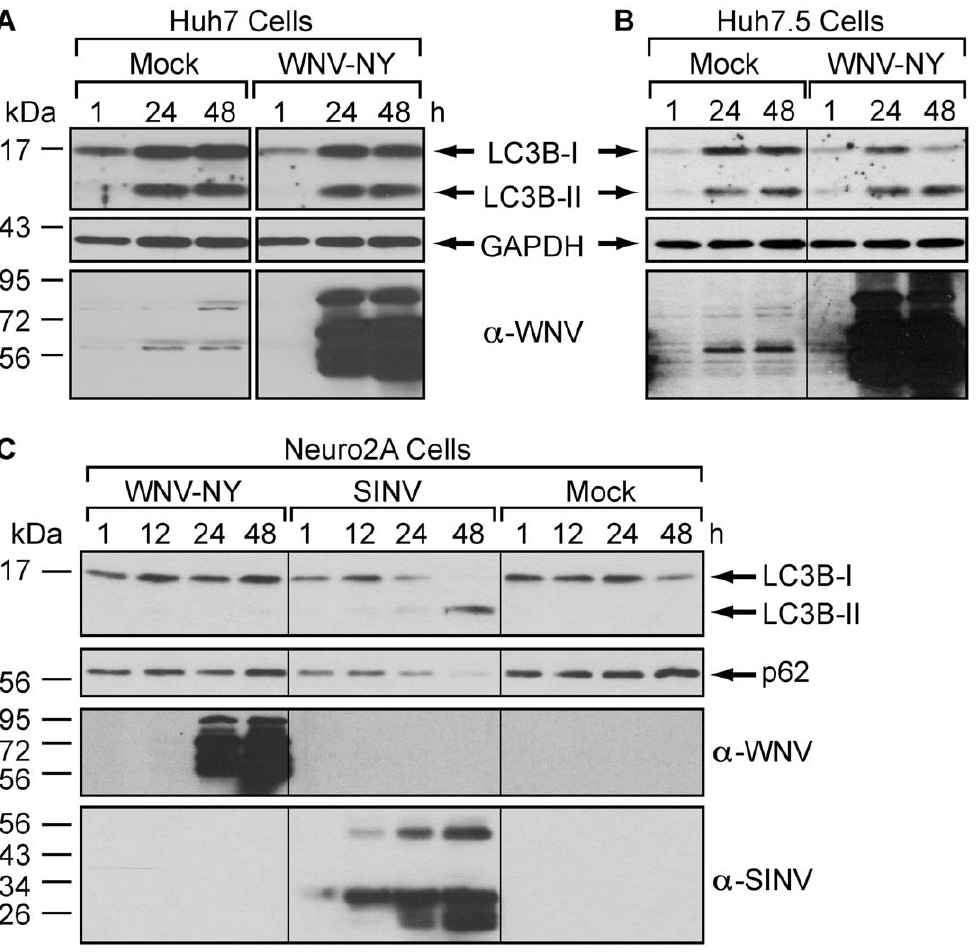
Figure 5. The autophagy pathway is not upregulated by WNV in established cell lines. (A and B) Effect of WNV infection on steady-state LC3B-II levels in Huh7 (A) or Huh7.5 (B) cells. Following mock or WNV-NY (MOI=3) infection, cells were grown in medium containing 10 m g/mL Pepstatin A and E64d. Whole cell lysates prepared at the indicated times (h) post-infection were subjected to immunoblot analysis for expression of LC3B (top), GAPDH (middle), and WNV (bottom). (C) Effect of WNV and SINV infection of steady-state LC3B-II and p62 levels in Neuro2A cells. Neuro2A cells were mock-infected or infected with WNV (MOI=3) or SINV (MOI=5) in the absence of protease inhibitors. Whole cell lysates prepared at the indicated times (h) post-infection were subjected to immunoblot analysis for expression of LC3B (top panel), p62 (second panel), WNV (third panel), and SINV (bottom panel).